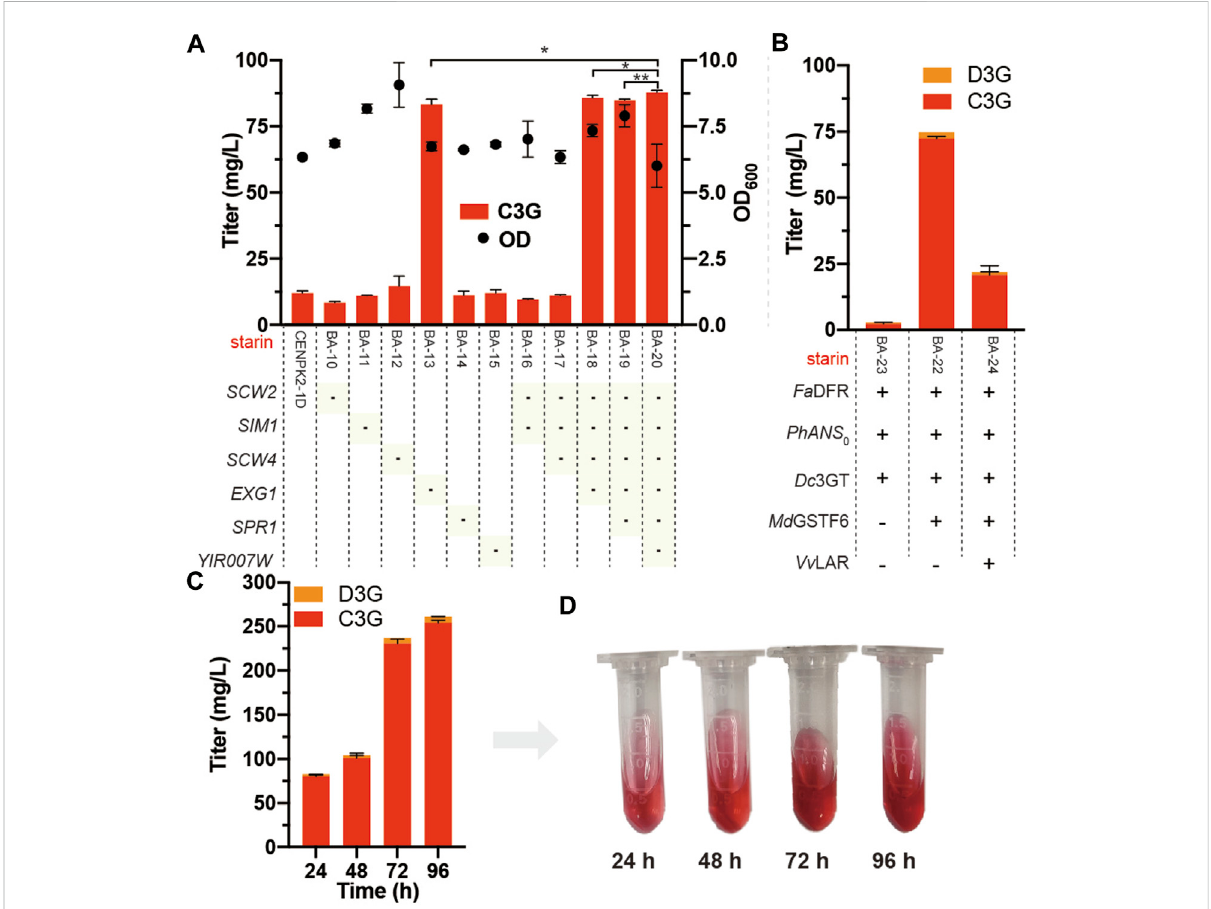
FIGURE 5 Knockout of anthocyanin-degrading enzymes (A) Marker of “ - ” indicates that the corresponding gene was knocked out in the CENPK2-1D. Student ’ s t test(one-tailed;two-sampleunequalvariance; p p < 0.05, pp p < 0.01, ppp p < 0.001)wasperformedbyOrigin2018 (B) Fa DFR, Ph ANS 0 ,and Md GSTF6werepromotedbyP TDH1 ,P GAL10 ,and P INO1 intheBA-21strainwith thepY26-TEF-GPDsupplemented with 500 mg/Ldihydro fl avonolsfor 24-h cultivation, respectively. Vv LAR was connected to the N-terminal of Fa DFR with a fl exible (GGGGS) 2 linker (CTACCGCCACCGCCGCTA CCGCCACCGCC) and promoted by P TDH1 (C) 96-h fermentation of the BA-22 strain; 500 mg/L dihydro fl avonols were added after 0 h, 1,000 mg/L dihydro fl avonols were added after 24 h, and 500 mg/L dihydro fl avonols were added after 48 h (D) Fermentation broth corresponding to